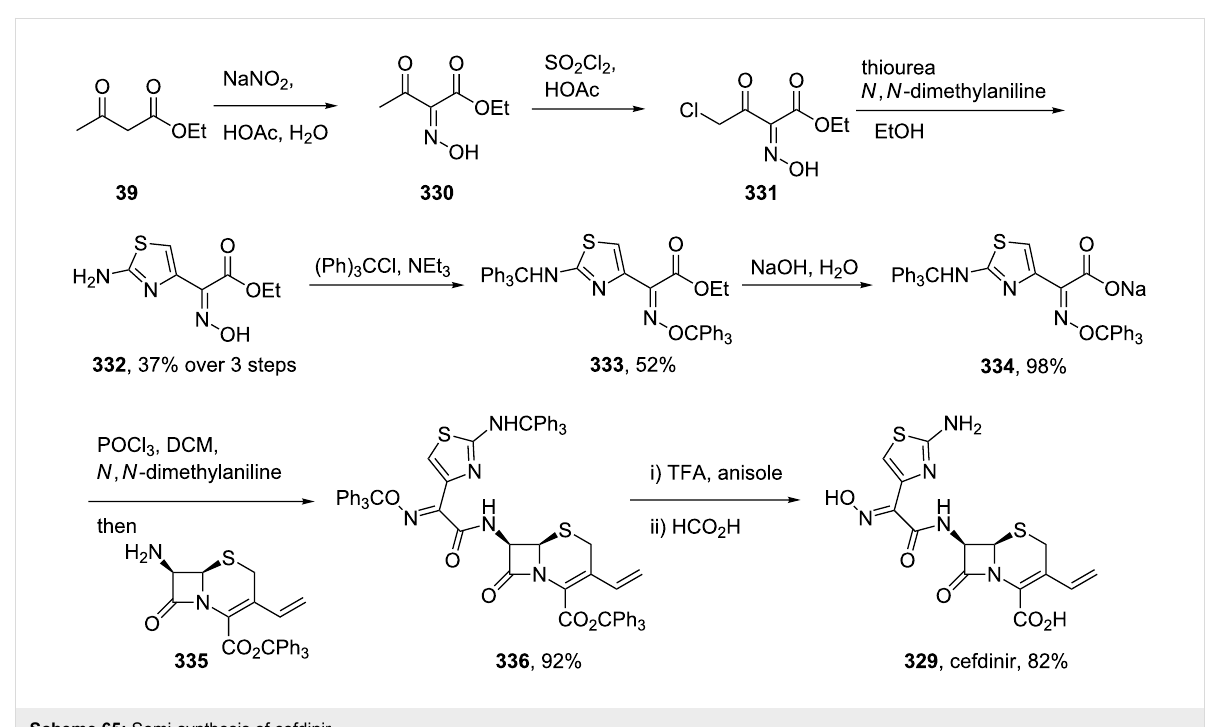
Scheme 65: Semi-synthesis of cefdinir.